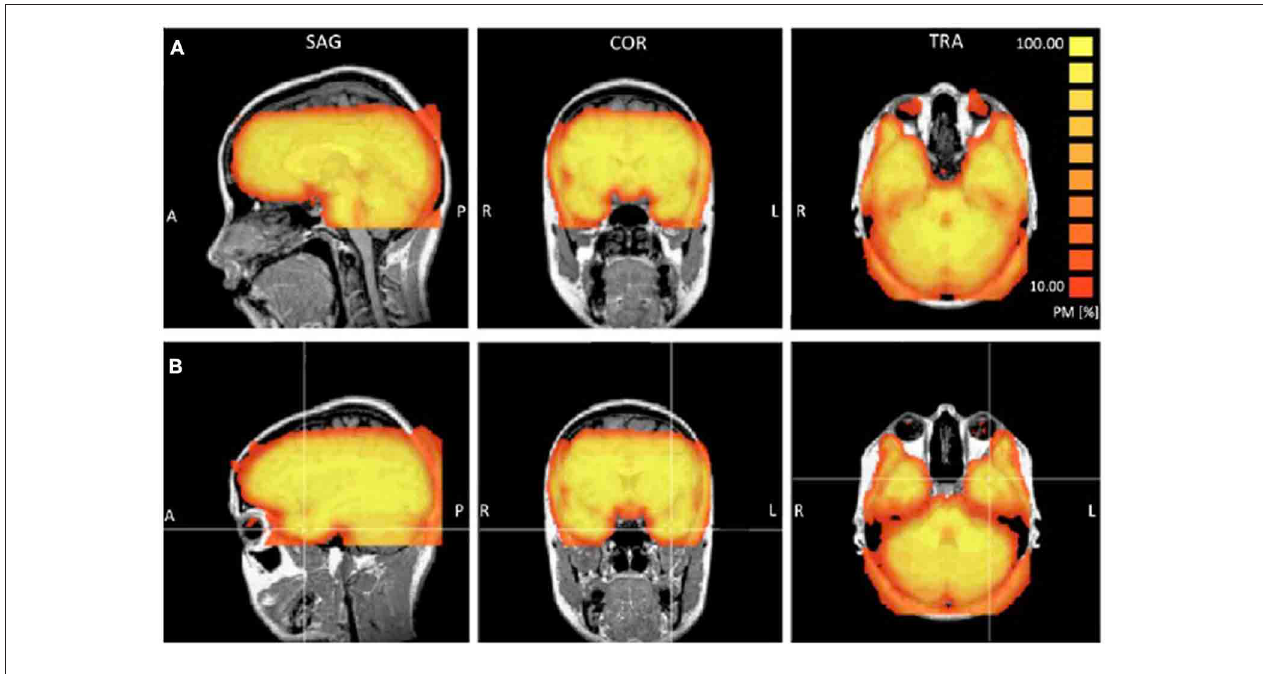
FIGURE 1 | Probability maps (PM) reporting the percentage or participants (ranging from 10 to 100%) that showed a TSNR greater than 40 for each voxel. Panel (A) provides a view